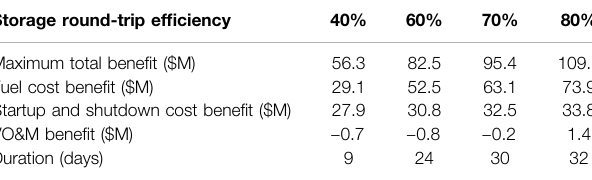
TABLE 4 | Summary of tested scenarios.